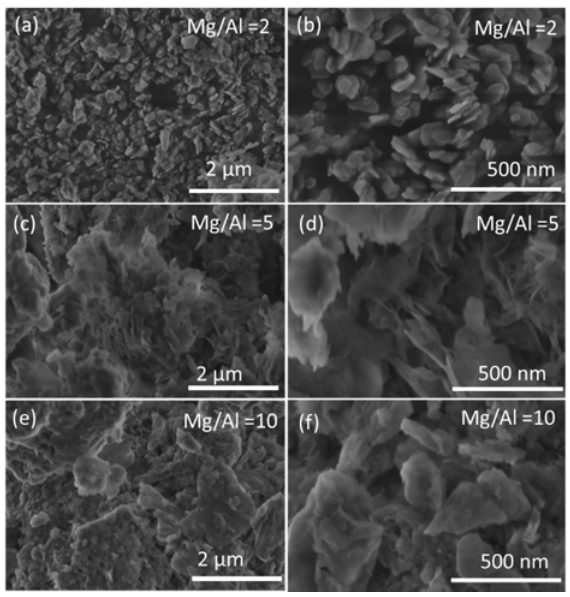
Figure 6. SEM images PtSn/Mg(Al)O with different Mg:Al molar ratios: ( a , b ) Mg:Al = 2:1; ( c , d ) Mg:Al = 5:1; ( e , f ) Mg:Al = 10:1.